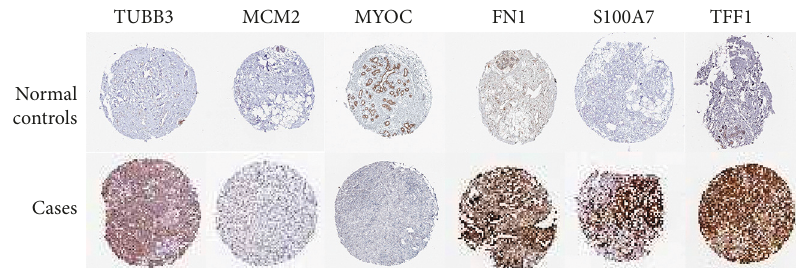
Figure 8: Expression validation of selected DEGs in GSE65194.